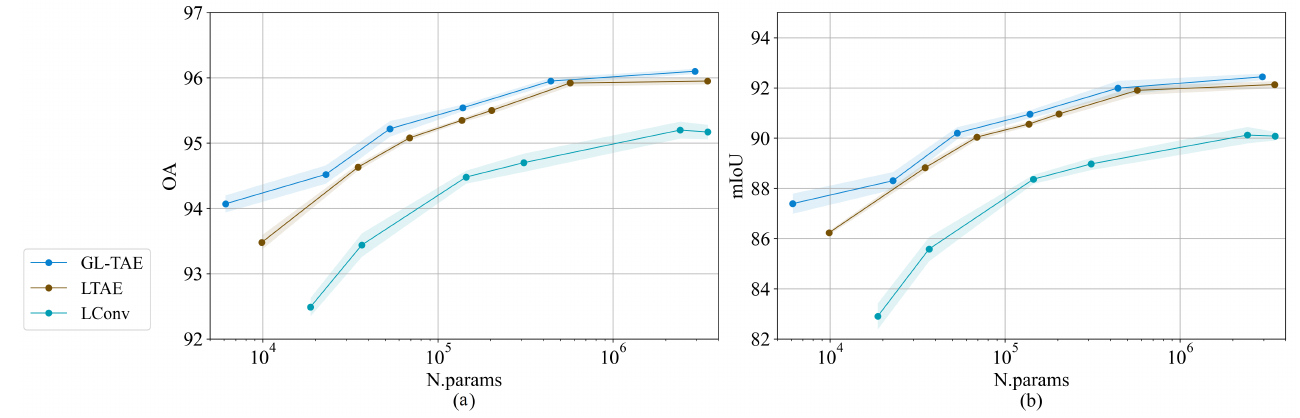
Figure 6. Performance of ( a ) OA and ( b ) mIoU on the TiSeLaC of LTAE and LConv; plotted with respect to the parameter numbers.